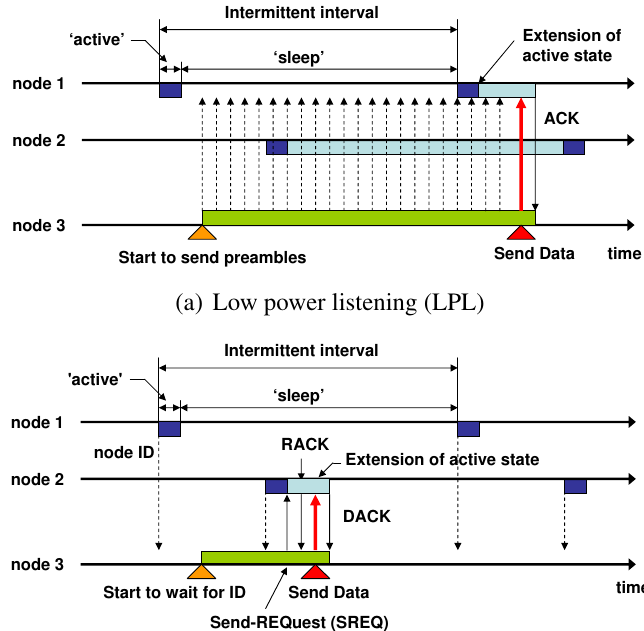
Figure 1. Asynchronous intermittent transmission